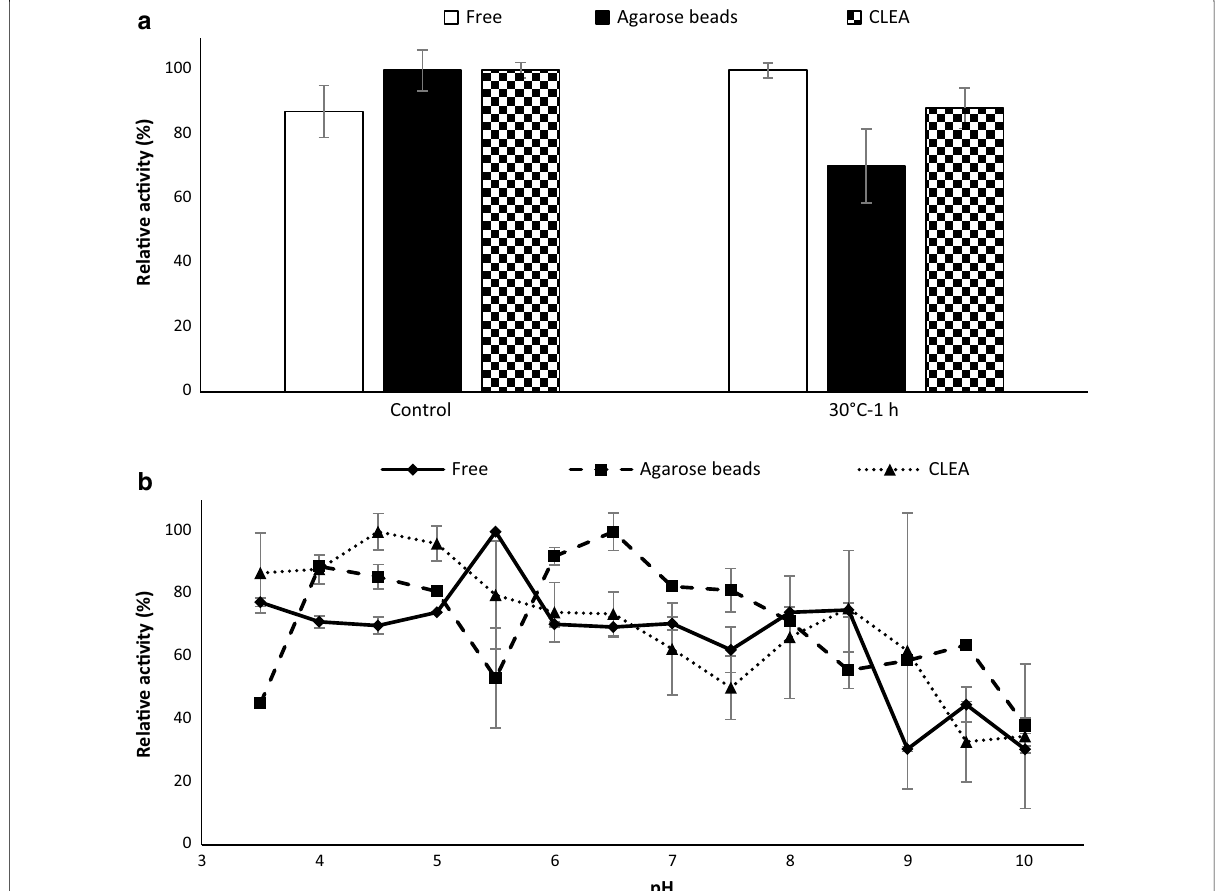
Fig. 6 Characterization of immobilized and free Sc Lac. a Thermal stability was determined by incubating the free and immobilized enzymes at 30 °C for 1 h and measuring the residual activities. Control assays were set up without heat treatment. b Optimum pH profiles of free Sc Lac, Sc Lac immobilized on agarose beads and Sc Lac